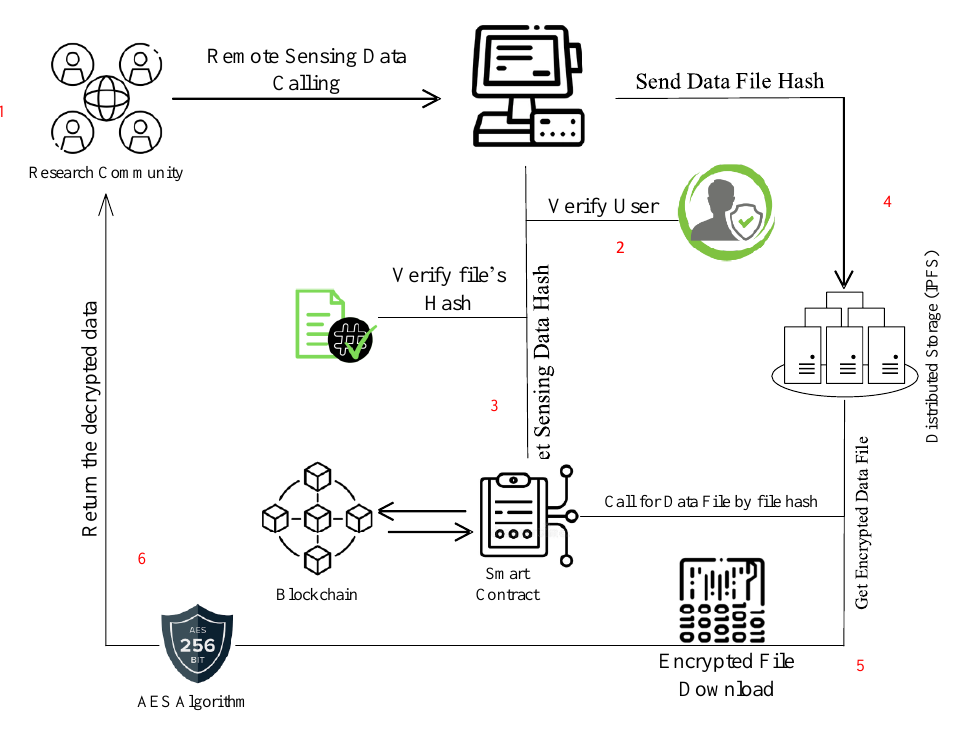
Figure 4. Data accessing process.